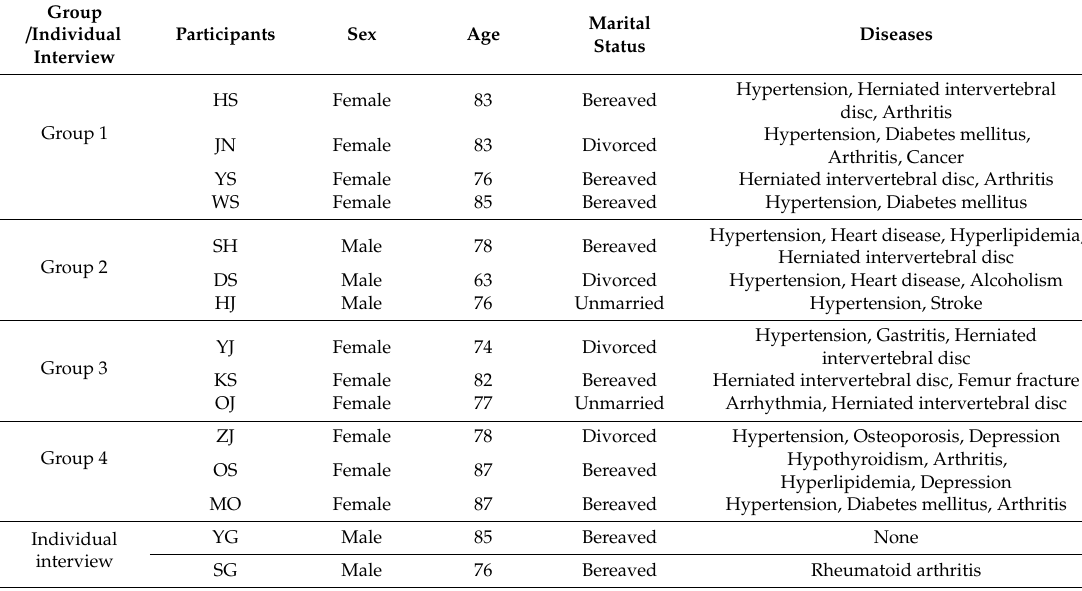
Table 1. Demographic characteristics of